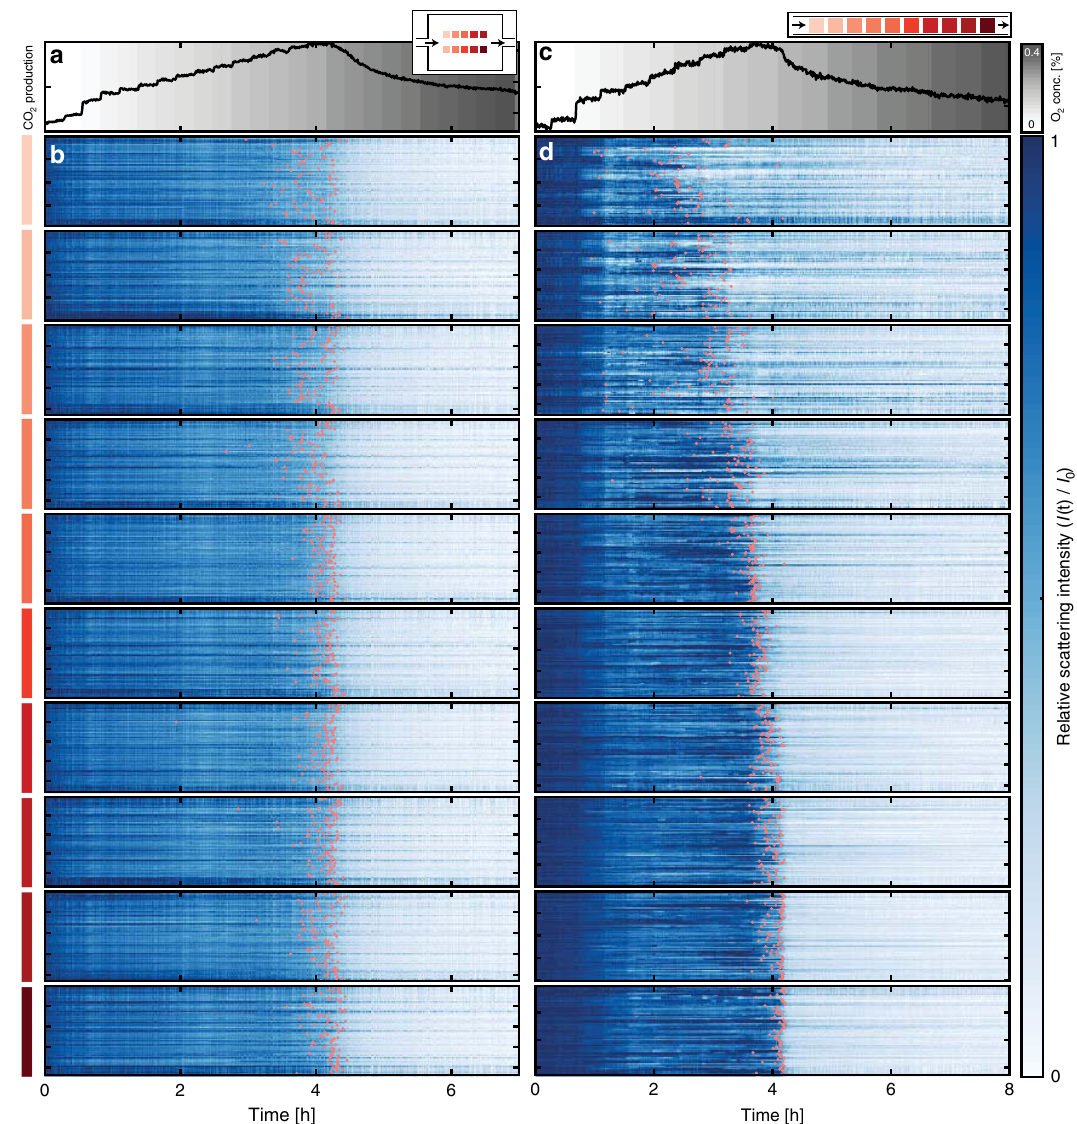
Fig. 6 Individual optical response from all 1000 Cu particles. a Integrated CO 2 production measured by the QMS from the well-mixed reactor during the stepwise increase of nominal inlet O 2 concentration depicted as the shaded background. The inset depicts the reactor geometry and indicates the position of the color-coded particle patches. Arrows depict reactant fl ow direction. b Scattering intensity time evolution from the individual nanoparticles in each patch (color-coded to the left). Each patch subset contains ~100 individual lines corresponding to a single particle in the patch. The orange markers indicate the oxidation time, τ ox , de fi ned as the time when each particle ’ s scattering intensity has decreased to 50% of the initial level. c , d The same as ( a , b ) but for the plug- fl ow reactor. The scattering intensity in each individual particle trace has been normalized to its initial intensity and minimum intensity after oxidation, to facilitate direct comparison between